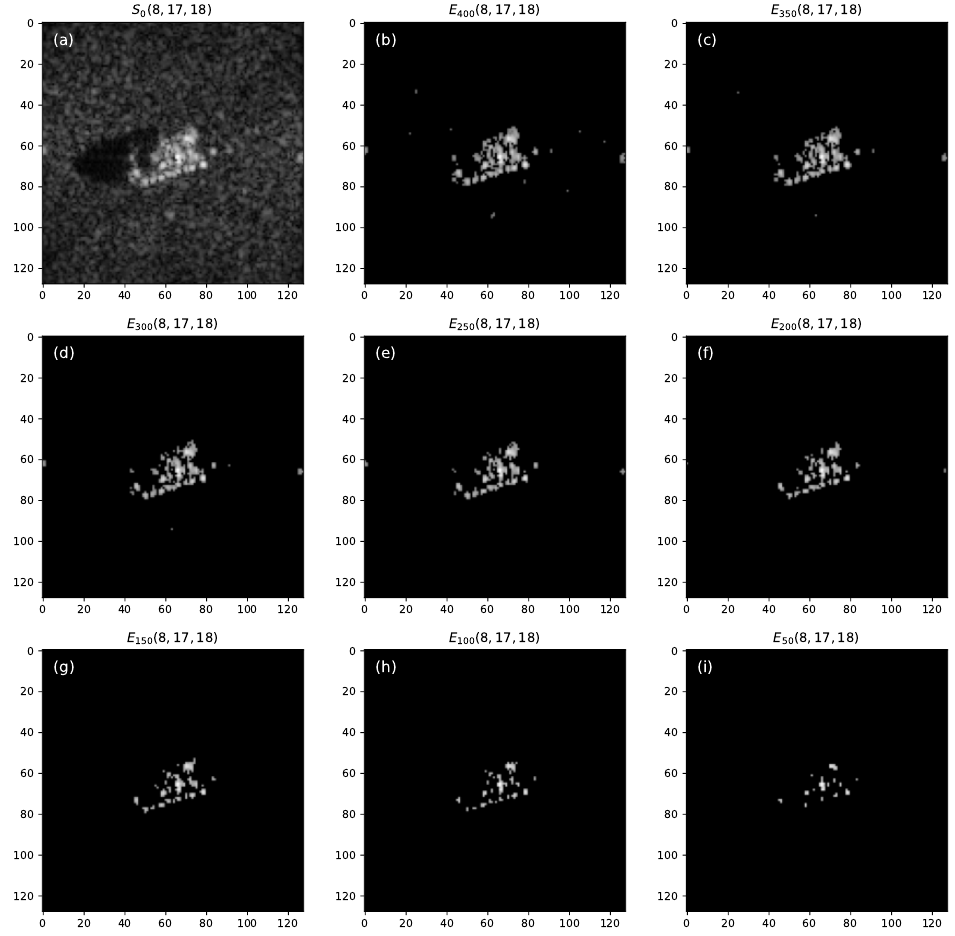
Figure 7. ( a ) Synthetic data chip of a T-72 tank— S 0 ( 8,17,18 ) . Reconstructed image with ( b ) 400, ( c ) 350, ( d ) 300, ( e ) 250, ( f ) 200, ( g ) 150, ( h ) 100, and ( i ) 50 scattering